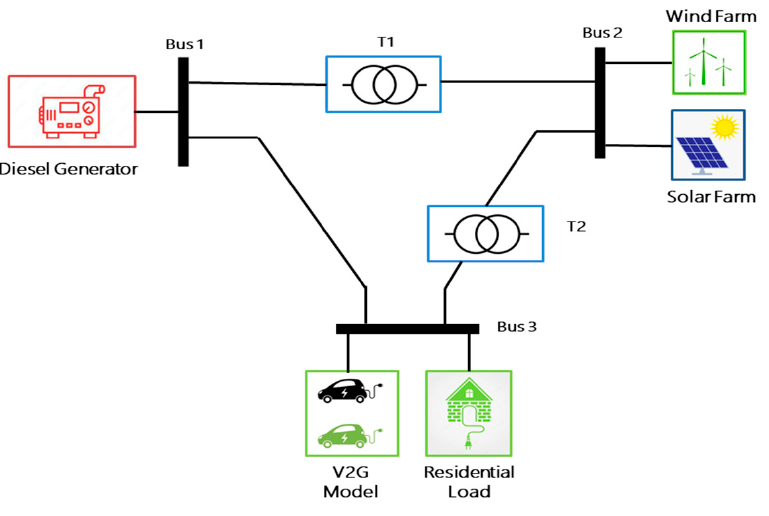
Figure 5. Design of the system.